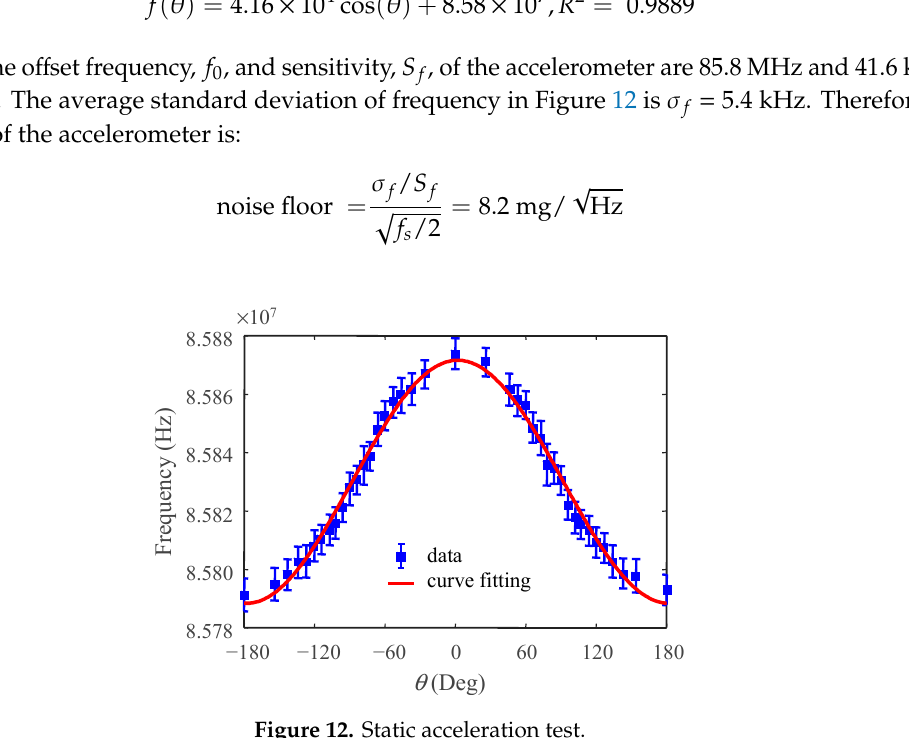
Figure 11. ( a ) Mixer output waveform, ( b ) Allan’s deviation at counter output.